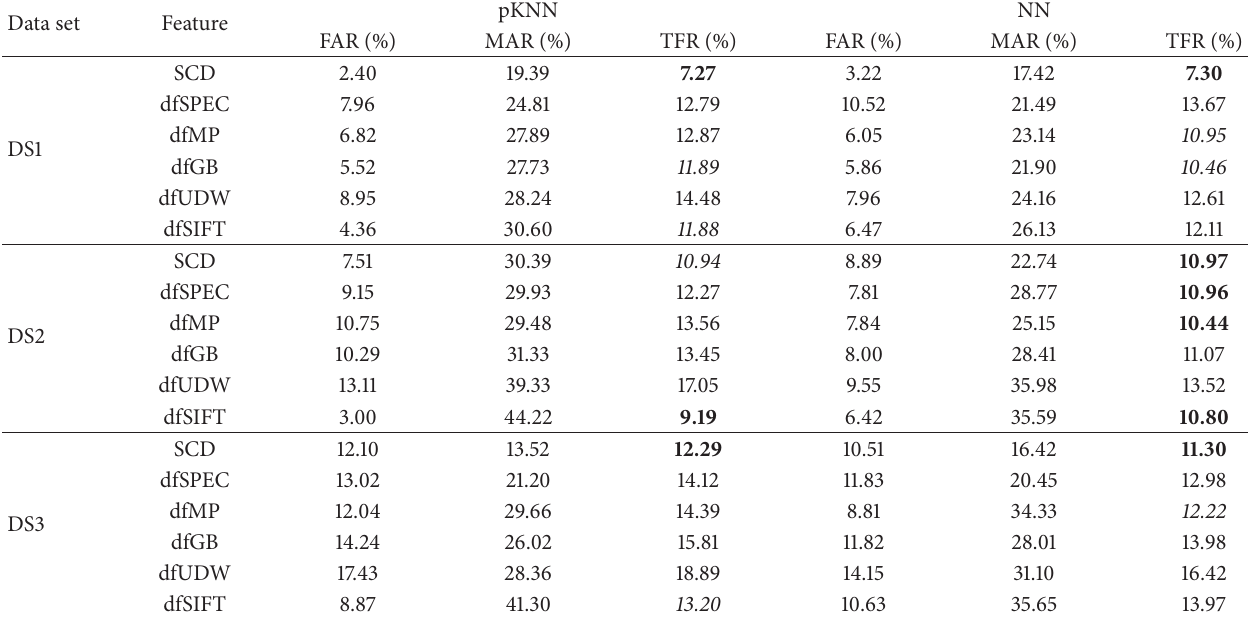
Table 3: Performance comparison of different change features.